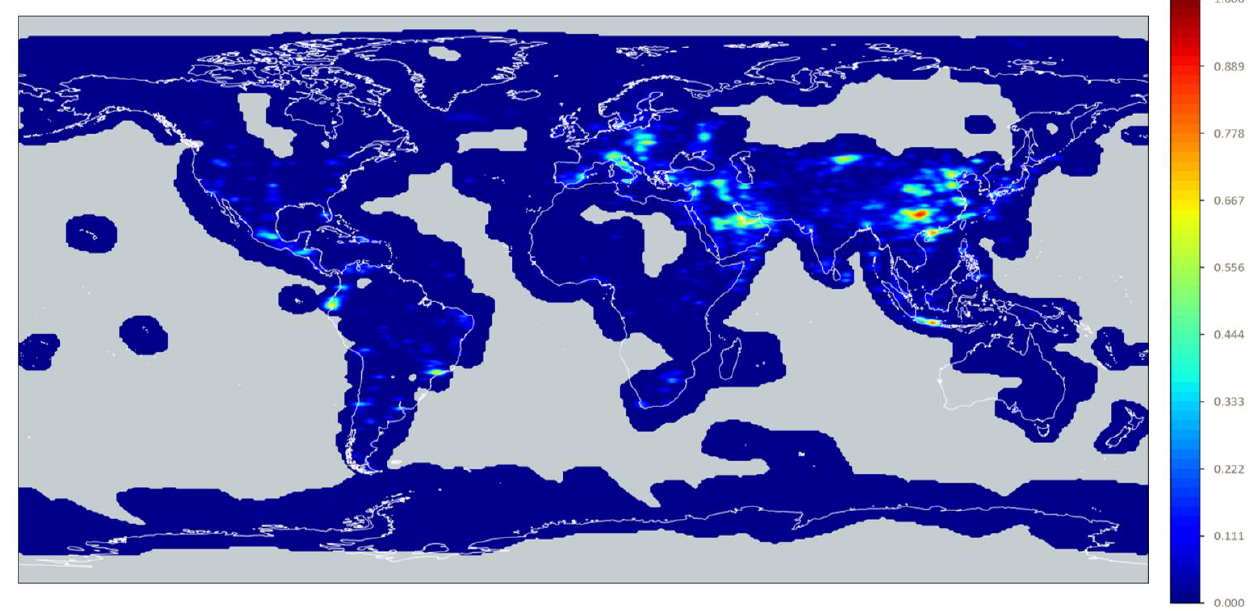
Figure 1. Map showing the probability of experiencing RFI of at least 1000 K [9].